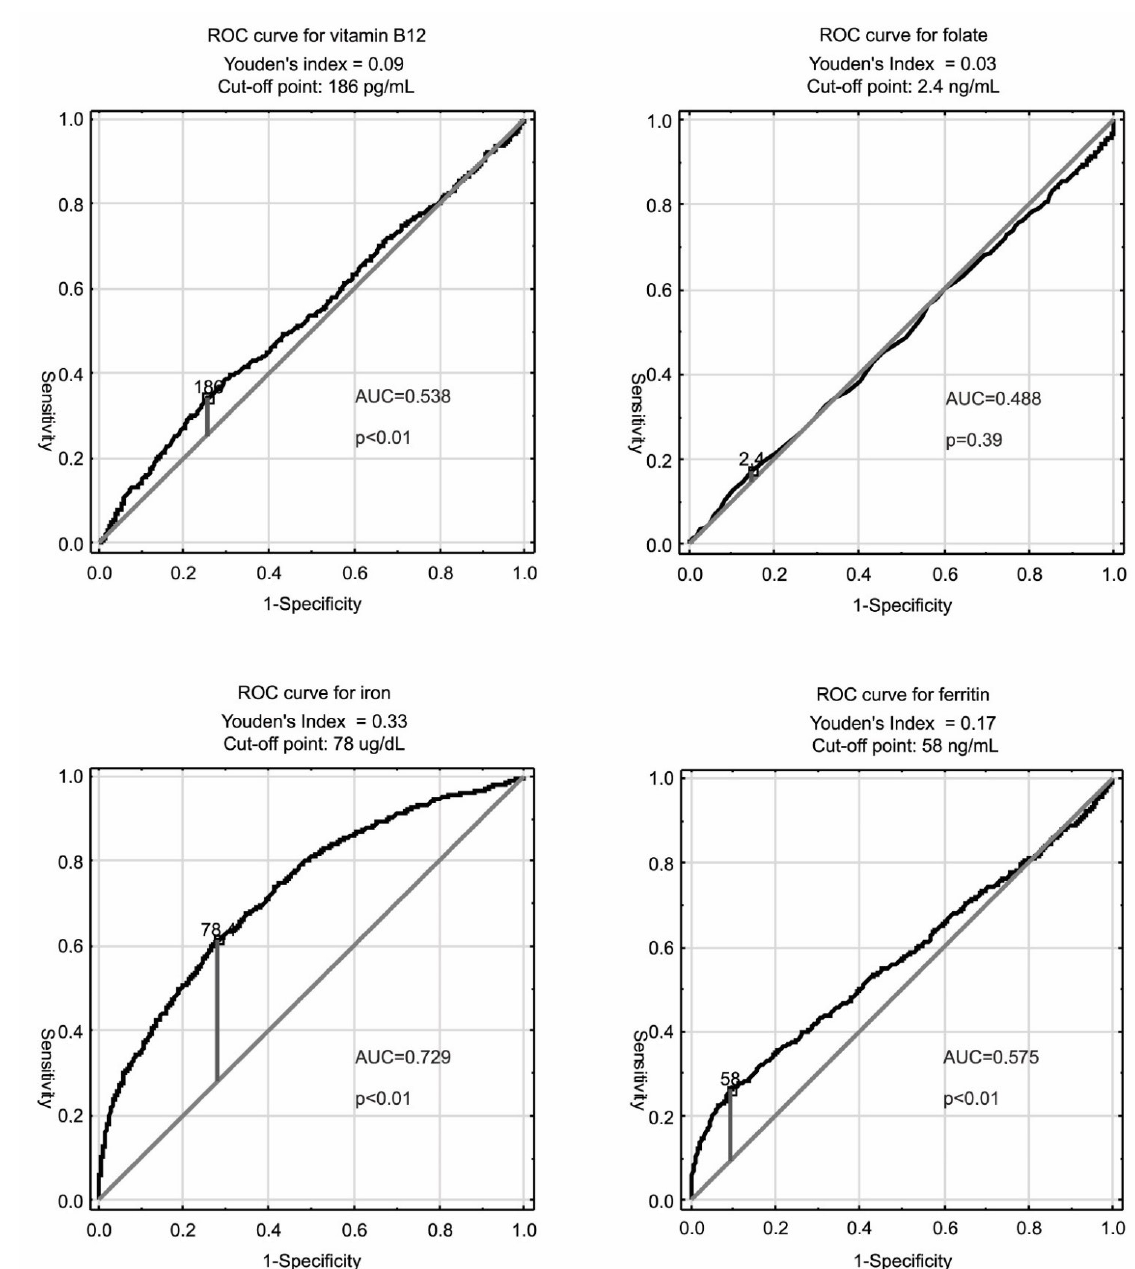
established as follows: for ferritin 58 ng/mL; for iron 78 µ g/dL; for folate 2.4 ng/mL; for vitamin B 12 186 pg/mL. ROC curves and AUC are presented in Figure 2. Etiologic classification of different types of anemia with cut-off points established according to three different methods, namely the WHO criteria, lower 2.5 percentile of studied population, and ROC curve analysis are presented in Table 2.